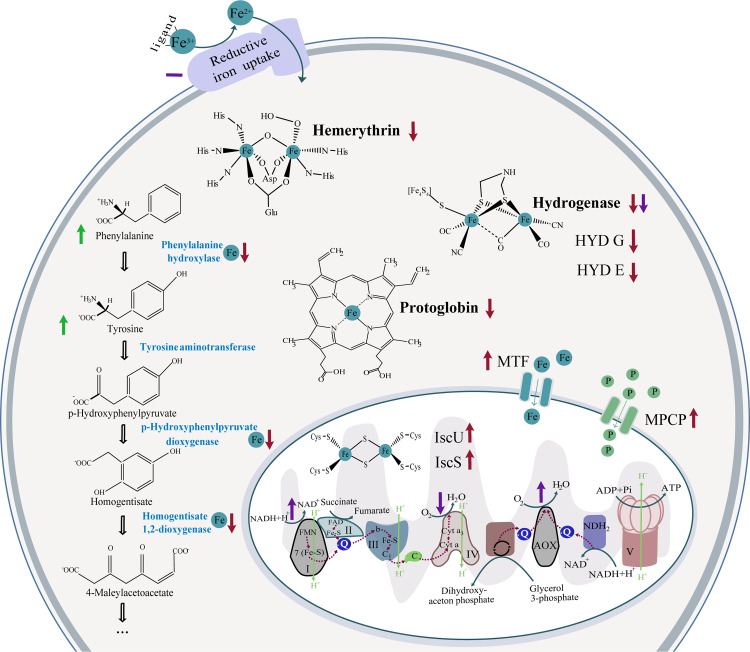
Illustration of the main effects of iron-deficient conditions on the selected cellular processes of N. fowleri.The results of proteomic analysis for selected proteins are depicted in red, the results from measured metabolite levels are in green and the assessed enzyme activities are in purple. Upwards pointing arrows stand for increased in the iron-deficient condition, downwards pointing arrows represent decreased in the iron-deficient conditions and dashes mean no significant change in the different iron conditions. Respiration chain complexes are represented by appropriate numbers, Fe represents iron-containing/involving protein/process. C, cytochrome C; MTF, mitoferrin; MPCP, mitochondrial phosphate carrier protein; P, phosphate; Q, ubiquinol/ubiquinone.